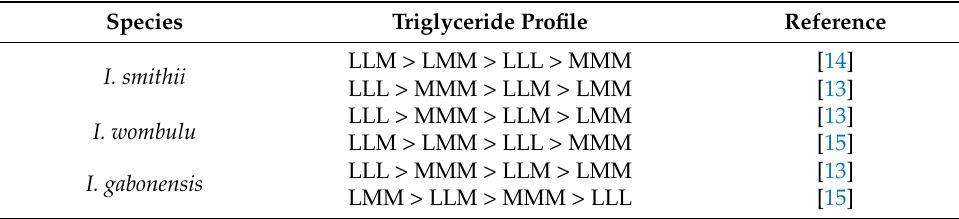
Table 1. Triglyceride profile of I. gabonensis , I. smithii and I. wombulu . Species Triglyceride Profile